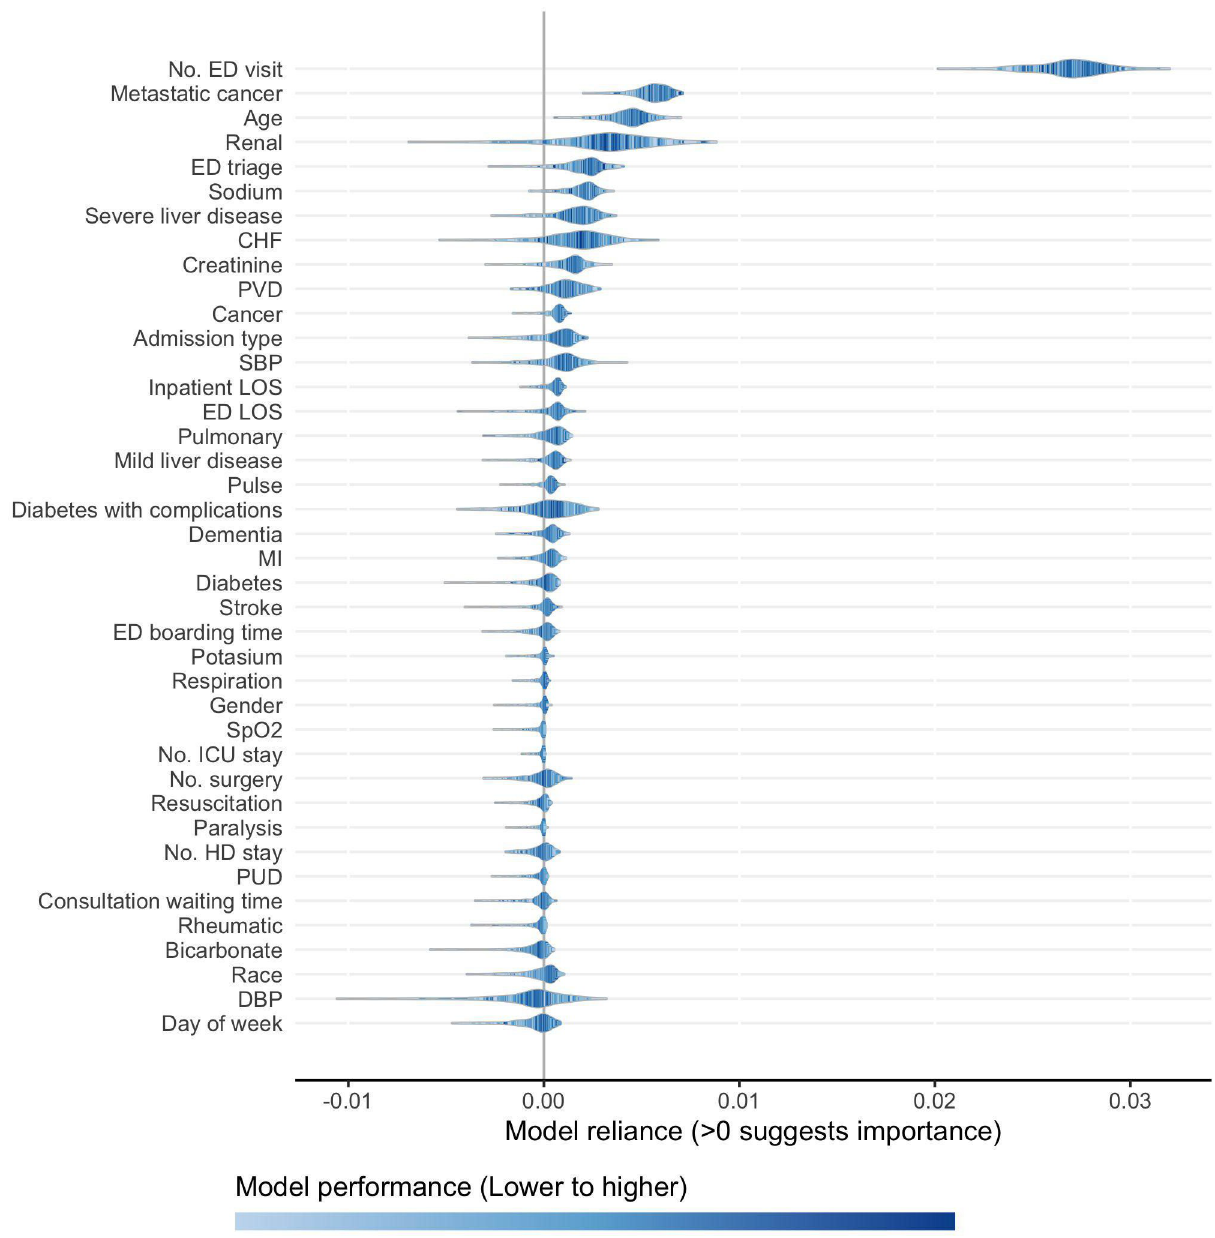
Fig 3. ShapleyVIC values from 350 nearly optimal logistic regression models, arranged in descending order of average ShapleyVIC values. Ventilation had zero ShapleyVIC value in all 350 models analyzed and was therefore not plotted. Number of ED visit is within 6 months before current inpatient stay. Number of surgery, ICU stay and HD stay are within 1 year before current inpatient stay. CHF: Congestive heart failure; DBP: diastolic blood pressure; ED: emergency department; HD: high dependency ward; ICU: intensive care unit; LOS: length of stay; MI: Myocardial infarction; PVD: Peripheral vascular disease; PUD: Peptic ulcer disease; SBP: systolic blood pressure; SpO 2 : blood oxygen saturation.